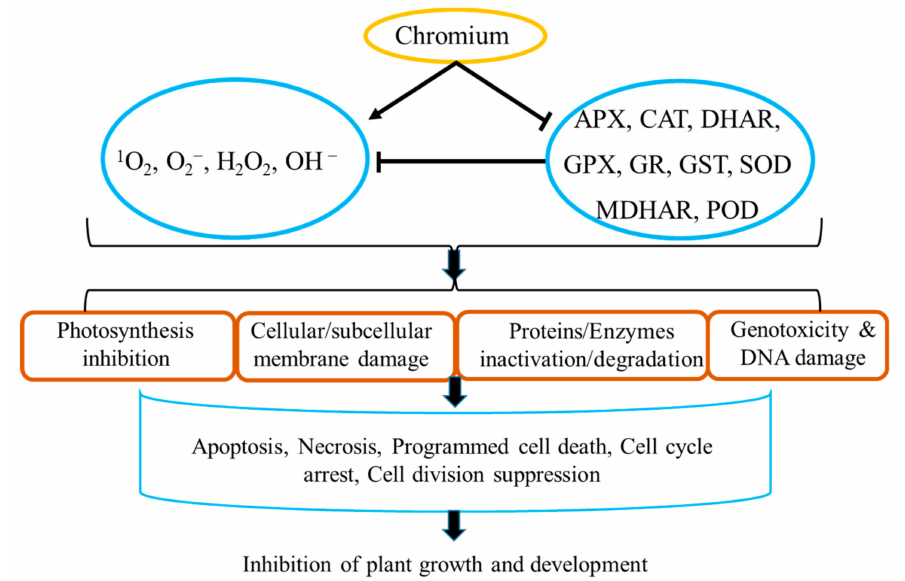
Figure 1. Cr(VI)-induced ROS mediated alteration in plants: Cr(VI)-induces ROS accumulation by suppressing enzymatic antioxidant system, which damages cellular and subcellular membranes; induces ultrastructural changes in cell organelles such as mitochondria, plastids, and thylakoids; inhibits protein and enzymes at transcriptional or post-transcriptional level as well as degrades various enzymes and proteins; and DNA damages. All of these alterations inhibit photosynthesis and trigger and enhance necrosis, apoptosis, and programmed cell death, and significantly inhibit plant growth and development. Superoxide (O 2 − ), hydrogen peroxide (H 2 O 2 ), hydroxyl ion (HO − ), and singlet oxygen ( 1 O 2 ). Ascorbate peroxidase (APX), catalase (CAT, dehydroascorbate reductase (DHAR), glutathione peroxidase (GPX), glutathione reductase (GR), glutathione S-transferase (GST), monodehydroascorbate reductase (MDHAR), peroxidase (POD), and superoxide dismutase (SOD). T-bars represent inhibition or suppression of the target, arrows represent promotion or upregulation of the target, and bold arrows represent the ultimate downstream result or impact of the